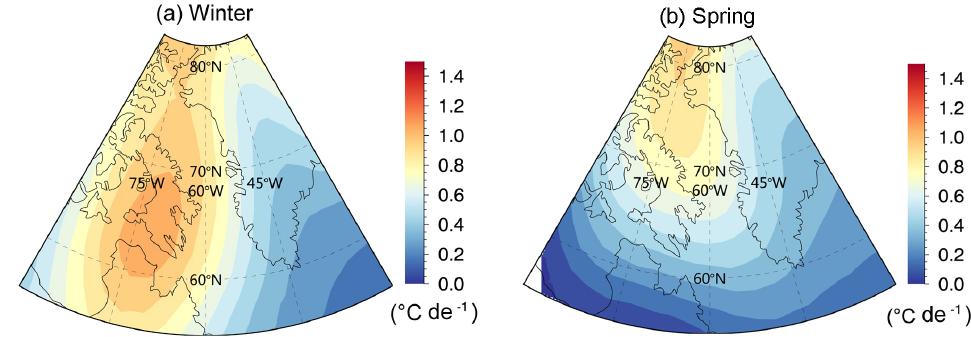
Figure 17. Surface air temperature trends for the period 1978–1979 to 2016–2017 during (a) winter and (b)